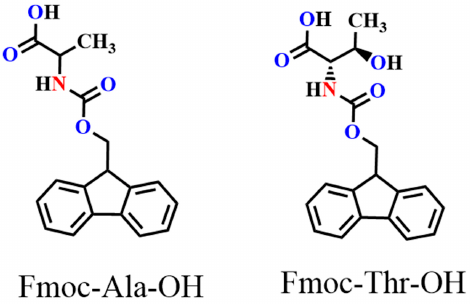
Figure 1. Structure of monomers Fmoc-Ala-OH and Fmoc-Thr-OH.